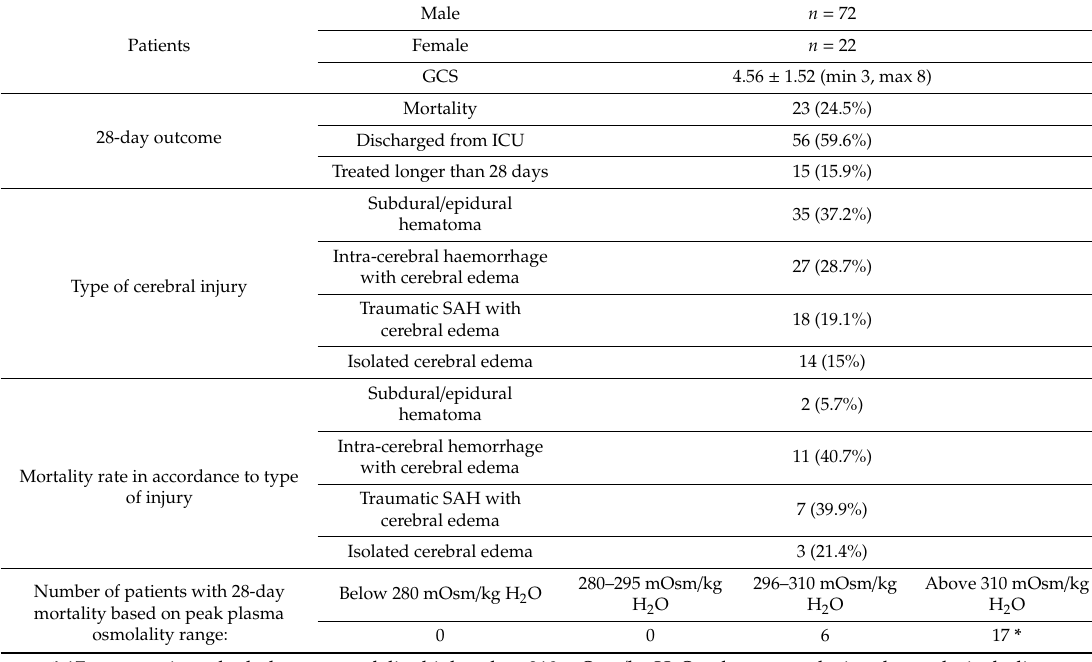
Table 1. Demographic data of studied population. GCS—Glasgow Coma Score, SAH—subarachnoid hemorrhage, ICU—Intensive Care